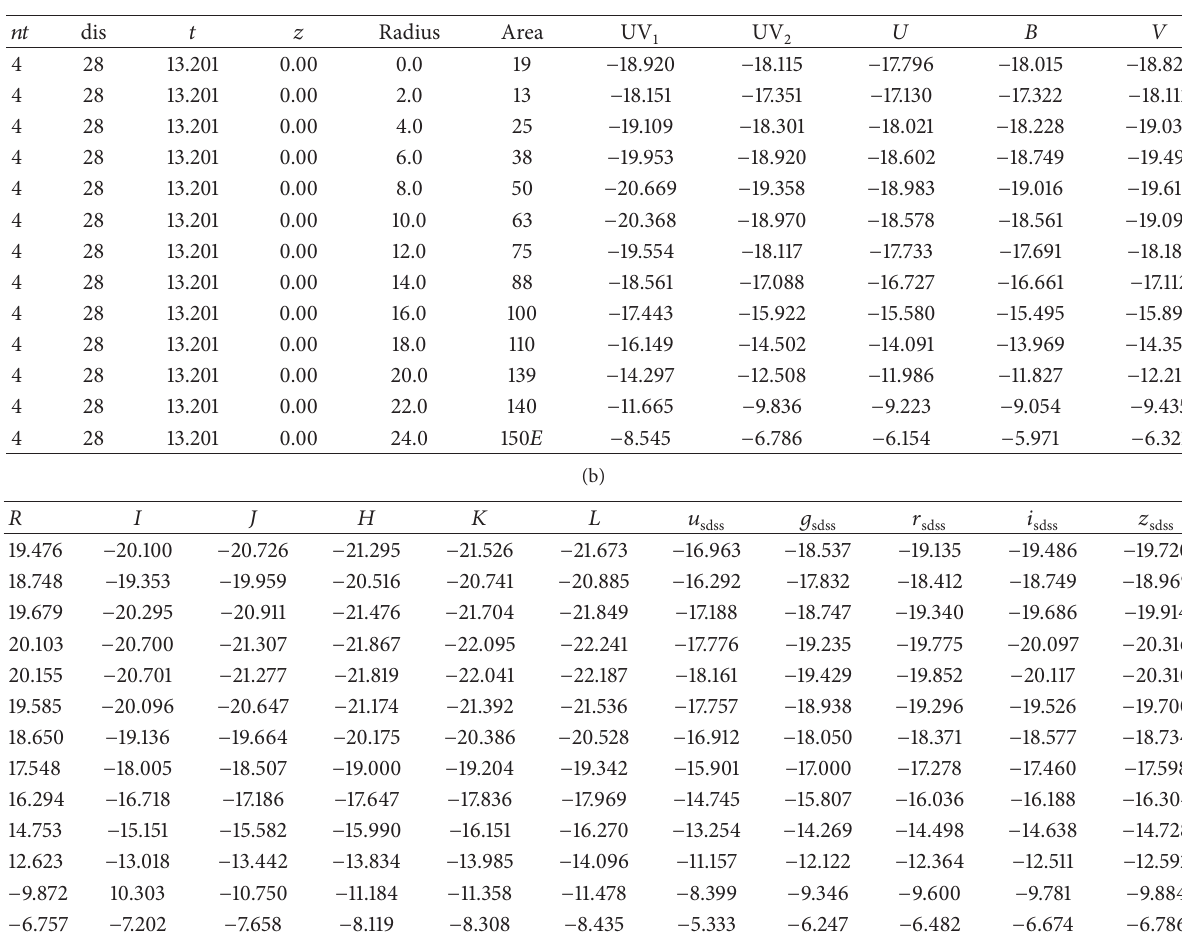
Table 4: Absolute magnitudes evolution along the time/redshift for the grid of models in Johnson and SDSS/SLOAN